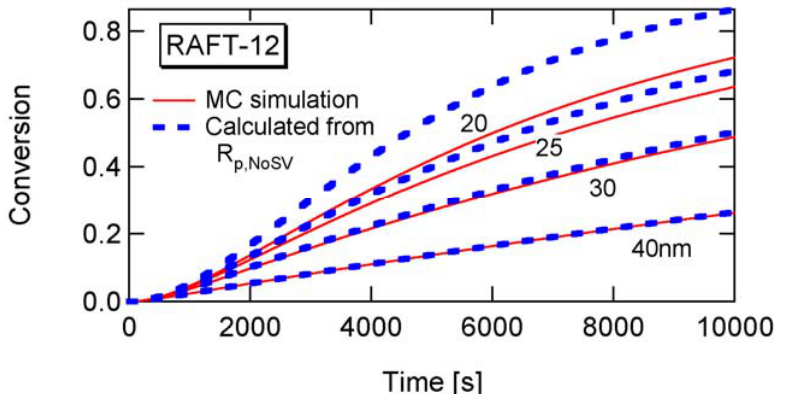
Figure 20. Conversion development of RAFT-12 with various particle sizes. Noticeable < 30 nm, as predicted in Figure difference is observed for D p